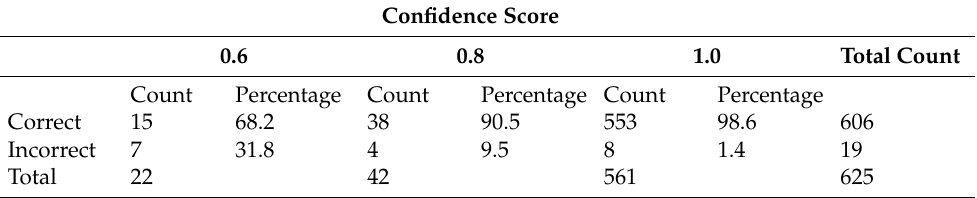
Table 3. A summary of the accuracy and confidence of the ensemble model predictions on the test set data. The ensemble model consisted of five networks. As a case study, the networks were trained using both SGAN and DANN methods and both sensor measurements to predict for the fast speed with no labelled data from the target domain. A confidence score of 0.6 indicates that three out of five models predicted that class, whereas a confidence score of 1.0 indicates that all models predicted the same class. Confidence Score 0.6 0.8 1.0 Total Count Count Percentage Count Percentage Count Percentage